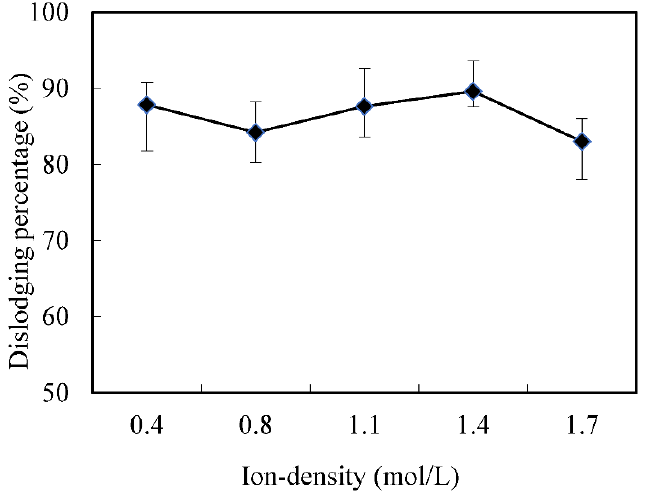
Figure 3. Effects of the ion-density in the feeding cell on the dislodging rate of Cr (VI).